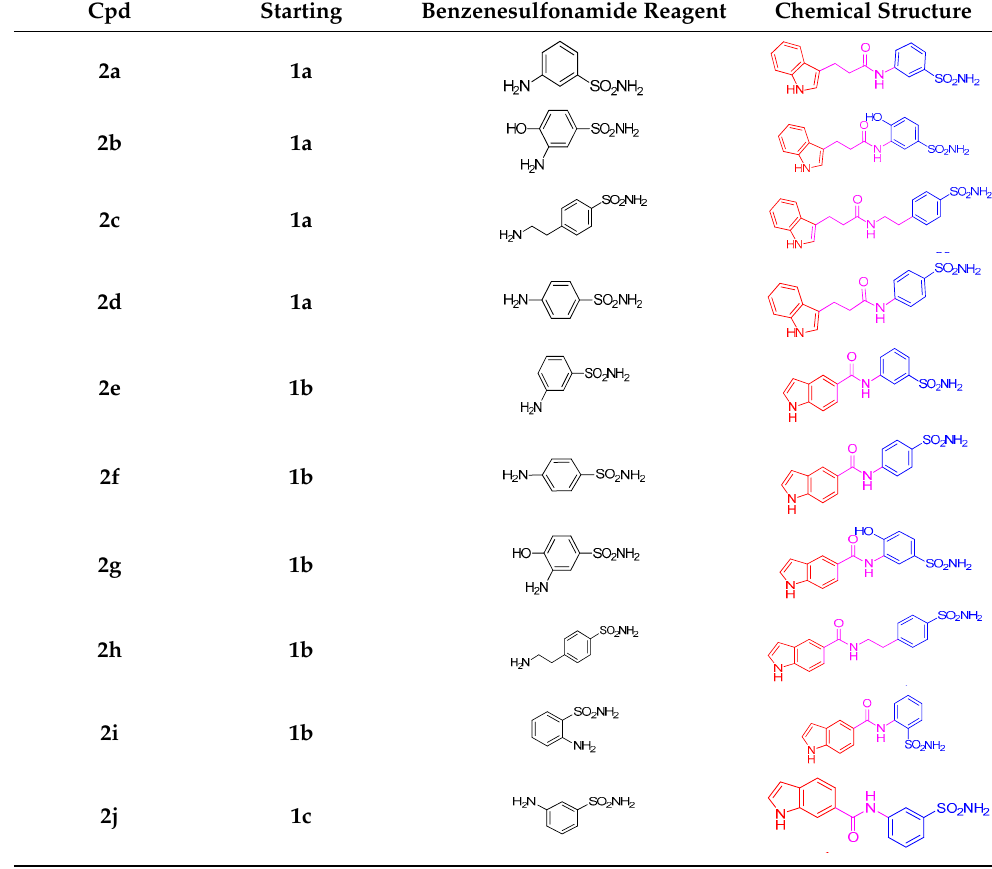
Table 1. Starting materials, reagents, and chemical structures of compounds 2a – o.